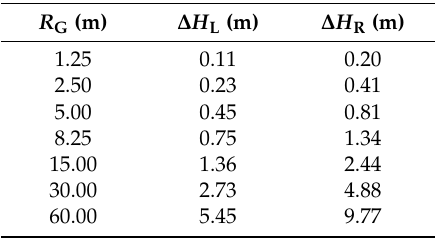
Table 4. Water level range of variability for the left and right banks slopes ( ∆ H L and ∆ H R ) corresponding to a horizontal bound displacement equal to R G . R G (m) ∆ H L (m)